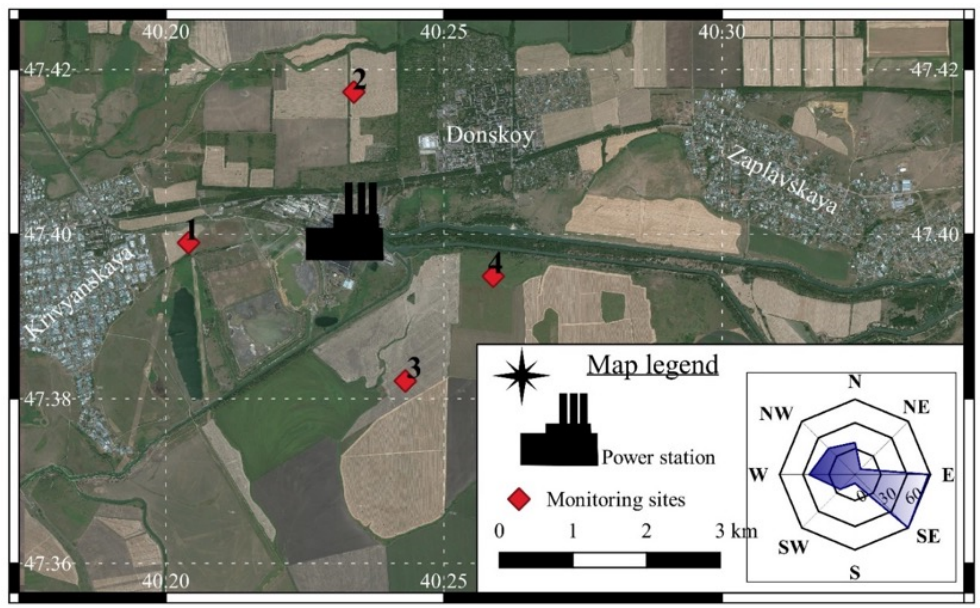
Figure 1. Location map of monitoring sites of agricultural lands located within the impact zone of the Novocherkassk Power Station.